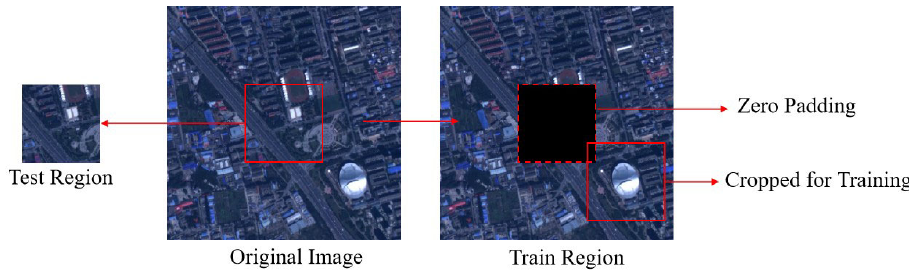
Figure 3. Examples of MS image training and testing regions for the GaoFen-2